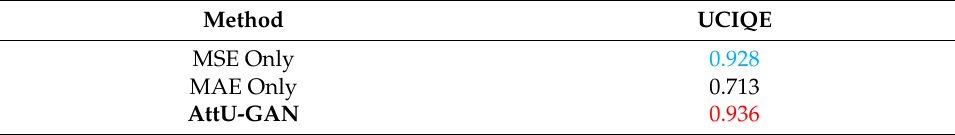
Table 5. No ‐ reference image quality evaluation (UCIQE). Table 5. No-reference image quality evaluation (UCIQE).